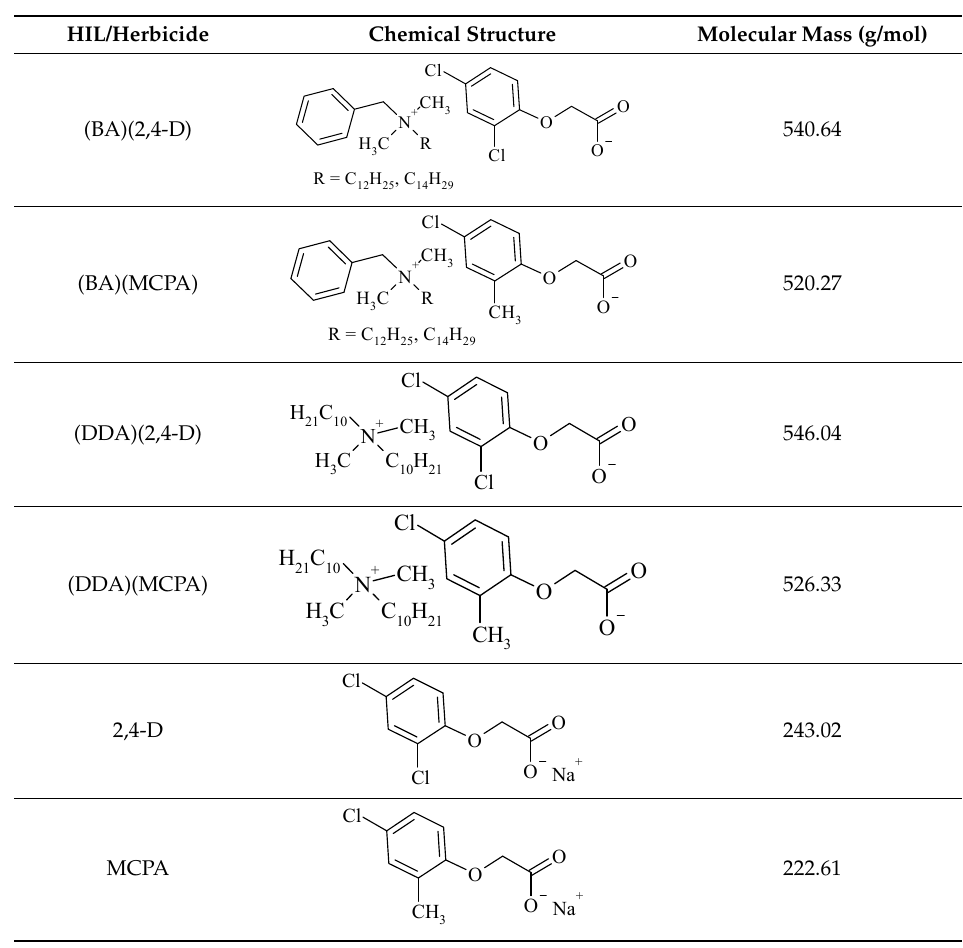
Table 1. Characteristics of tested herbicidal ionic liquids (HILs) and herbicides.